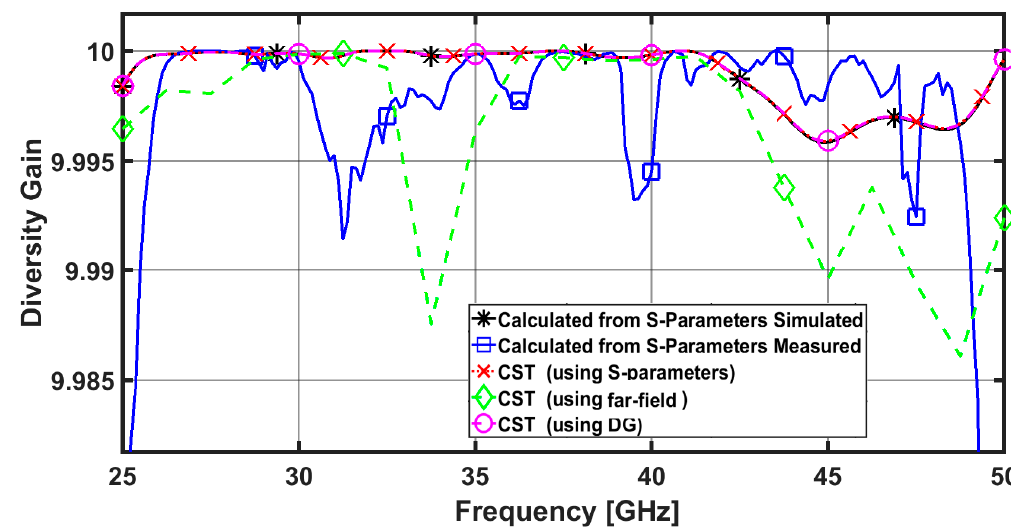
Figure 8. DG between ports 1 and 2 for the proposed four-element MIMO antenna.